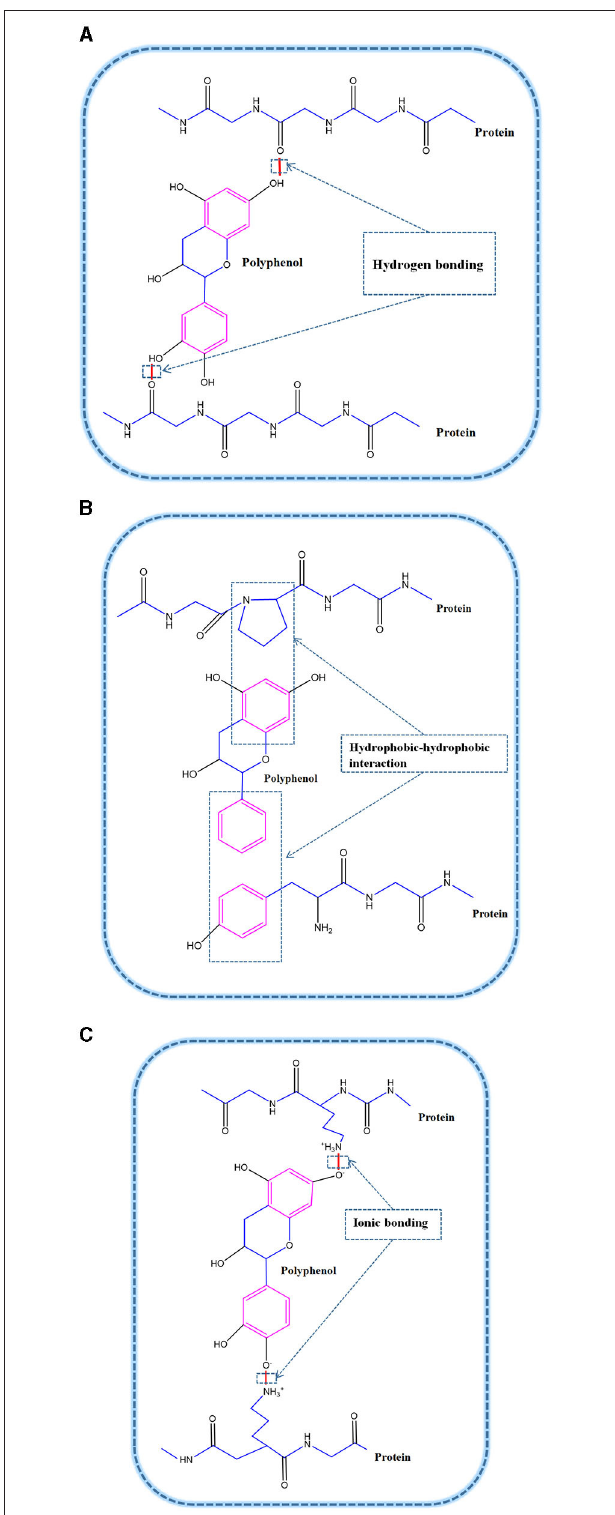
FIGURE 2 | Non-covalent interactions between proteins and polyphenols: (A) Hydrogen bonding; (B) Hydrophobic-hydrophobic interaction; (C) Ionic